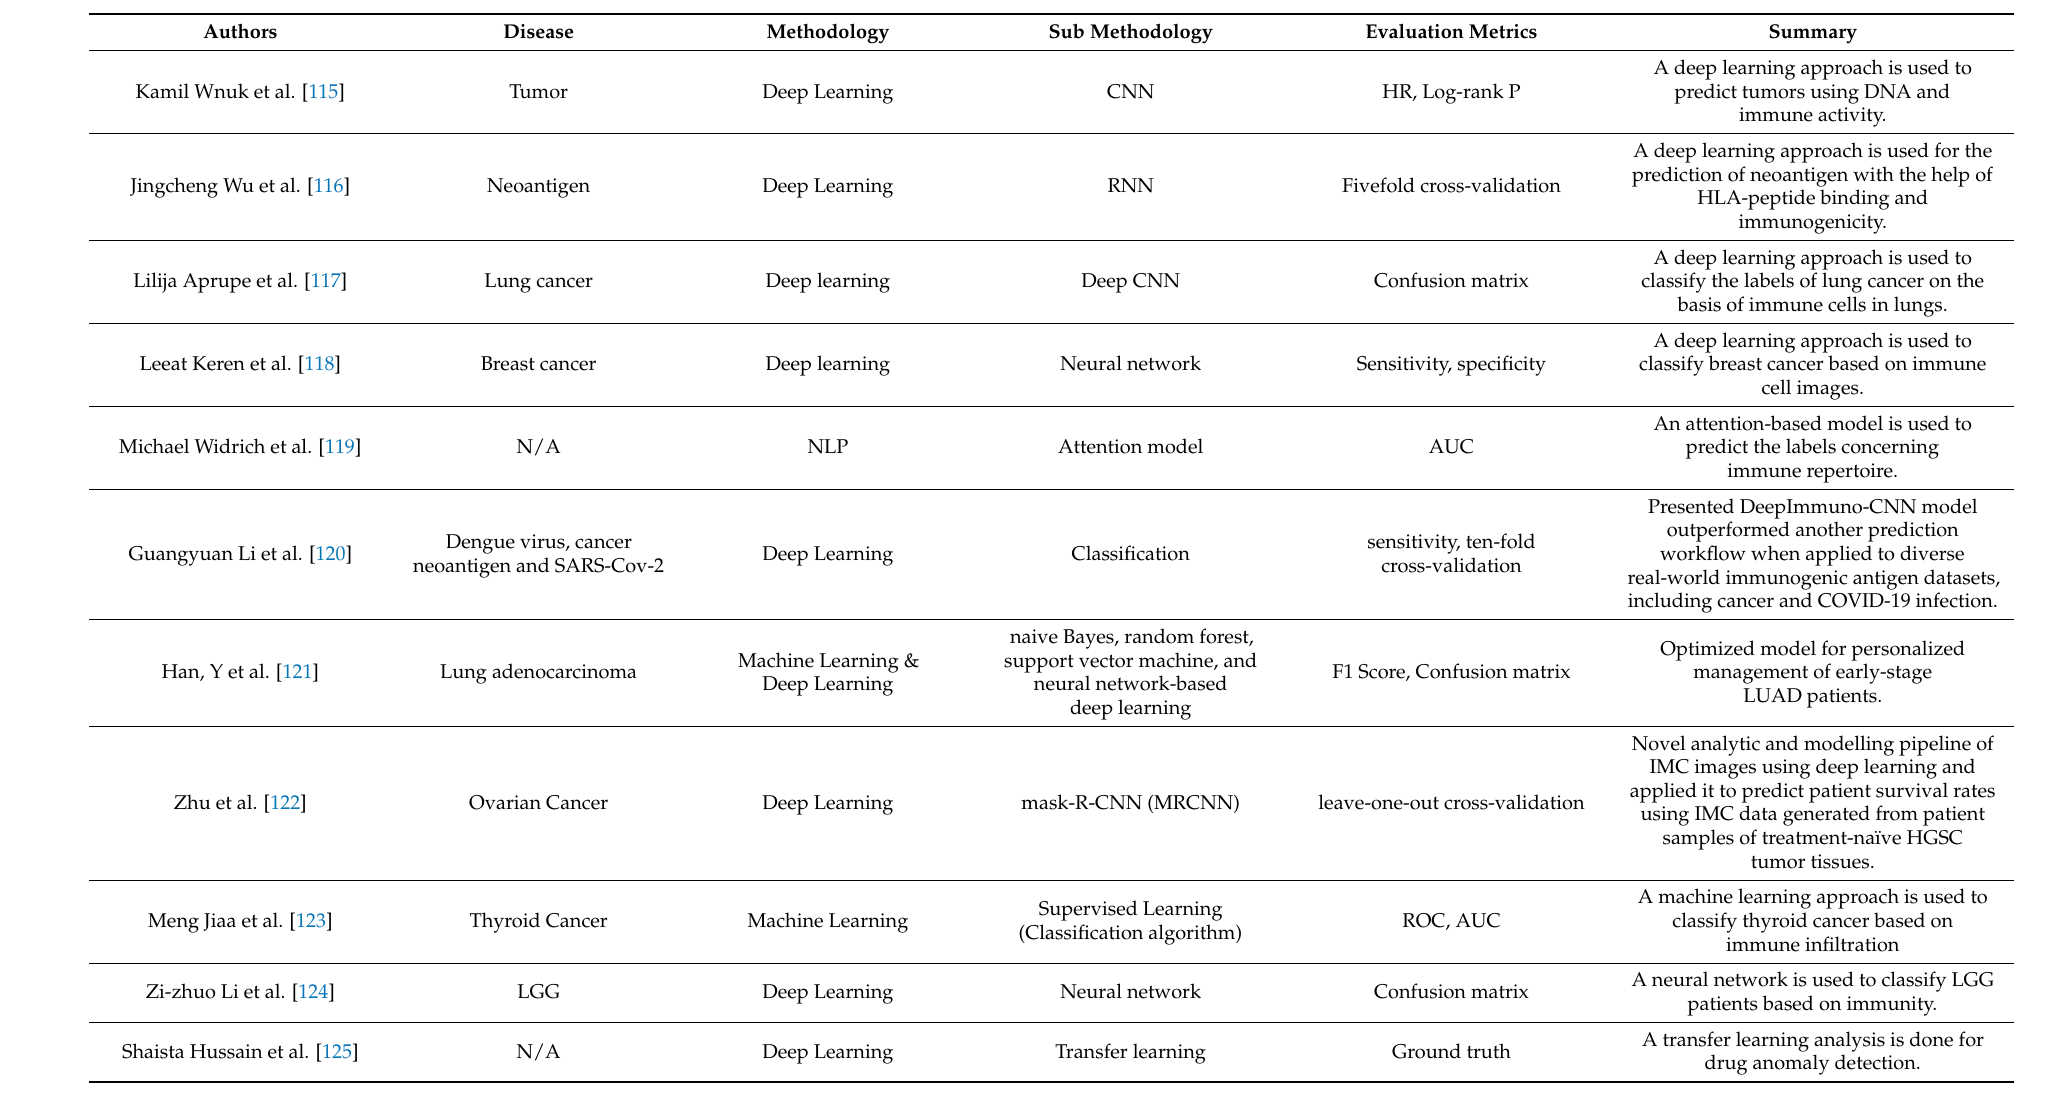
Table 6. A Review of Applications of Deep Learning in